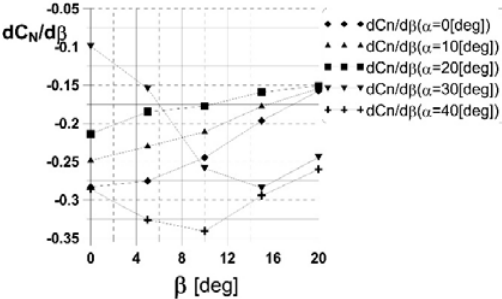
Fig. 16. Stability derivatives ∂C n /∂β – yaw moment coefficients versus sideslip angle